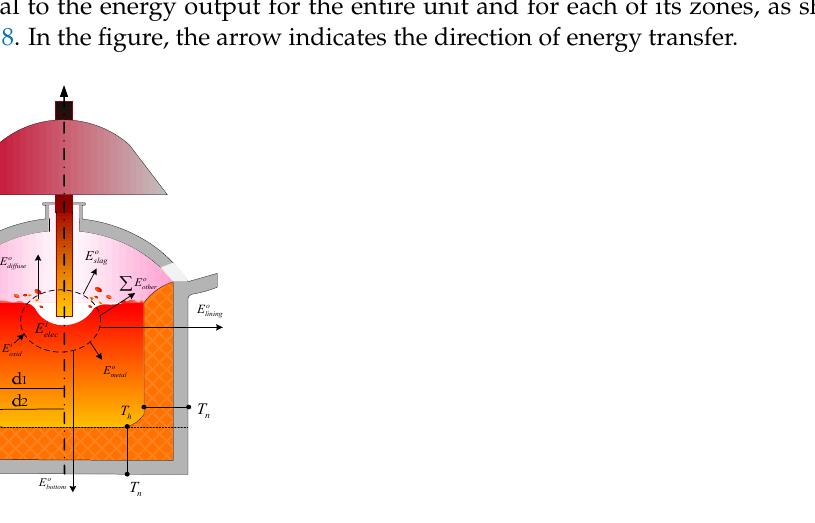
shown in Equations (9) and (10)